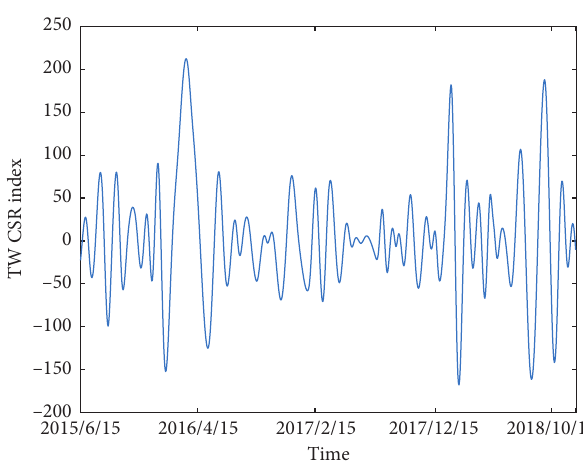
Figure 11: EMD analysis of the Taiwan CSR index to get